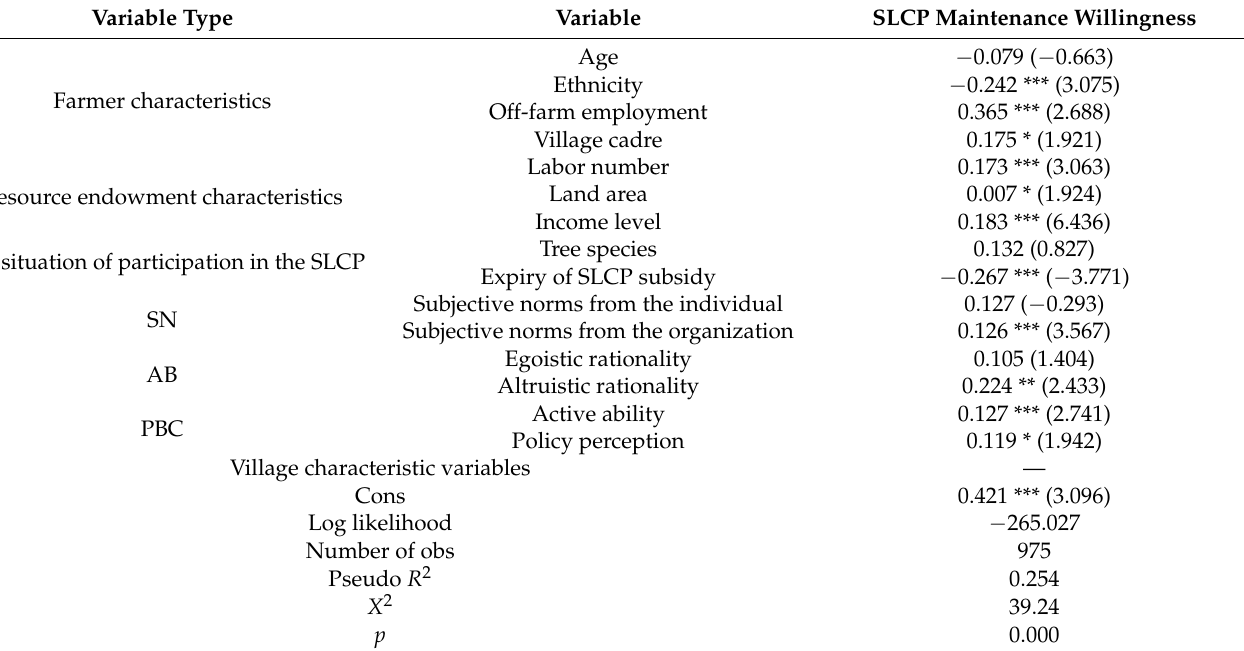
Table 4. Regression results of the logit